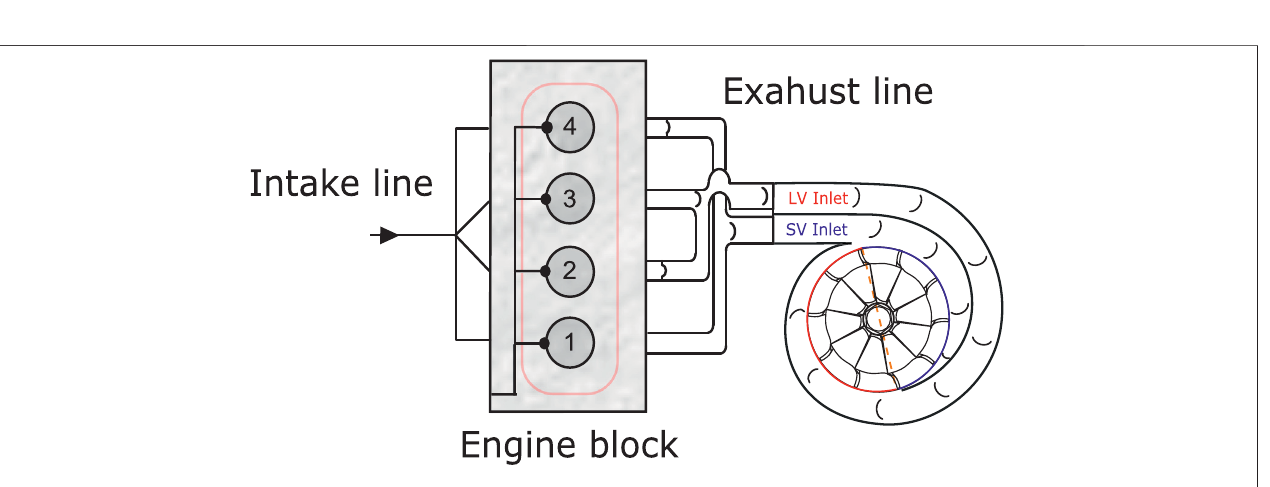
FIGURE 4 | Dual volute turbine connection with the engine